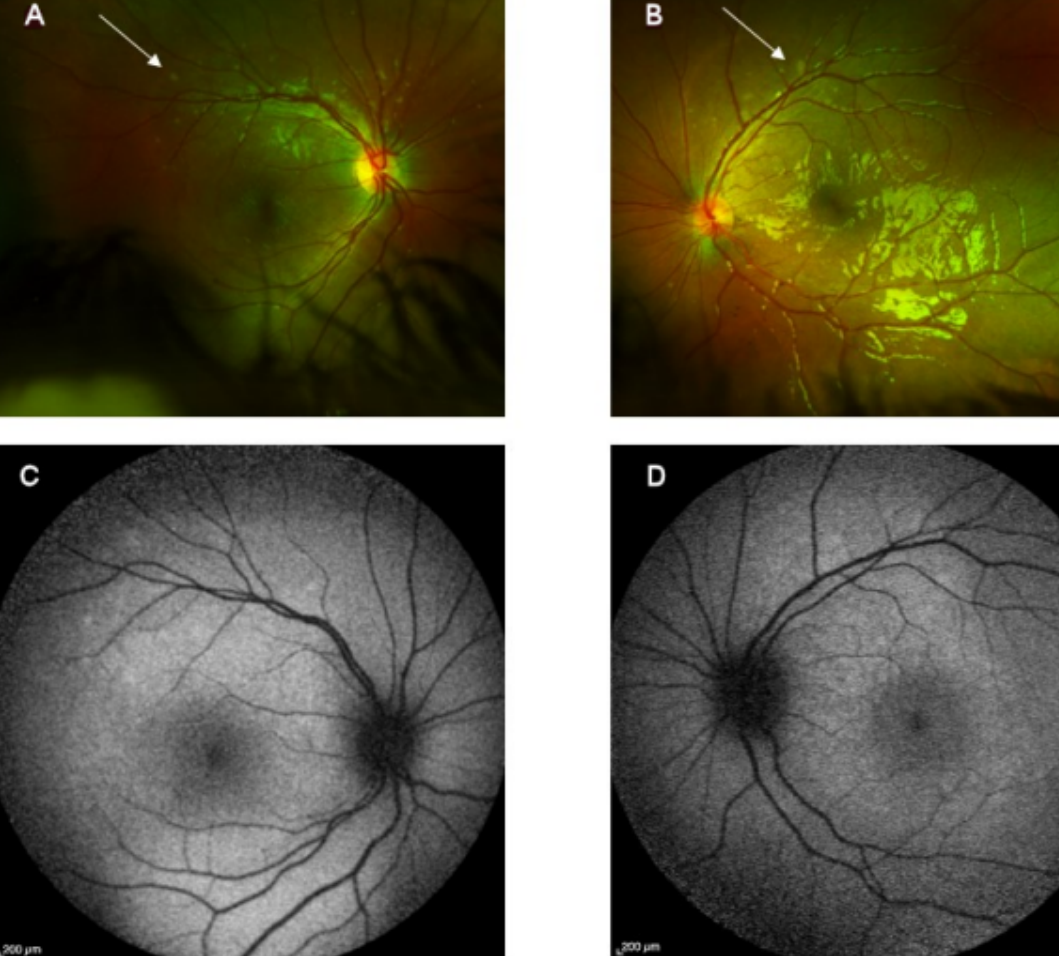
Figure 3: Fundoscopic images three weeks after initial presentation show multiple yellow deposits scattered around the vascular arcades (A and B, see arrows), with corresponding mild hyperautofluorescence (C,